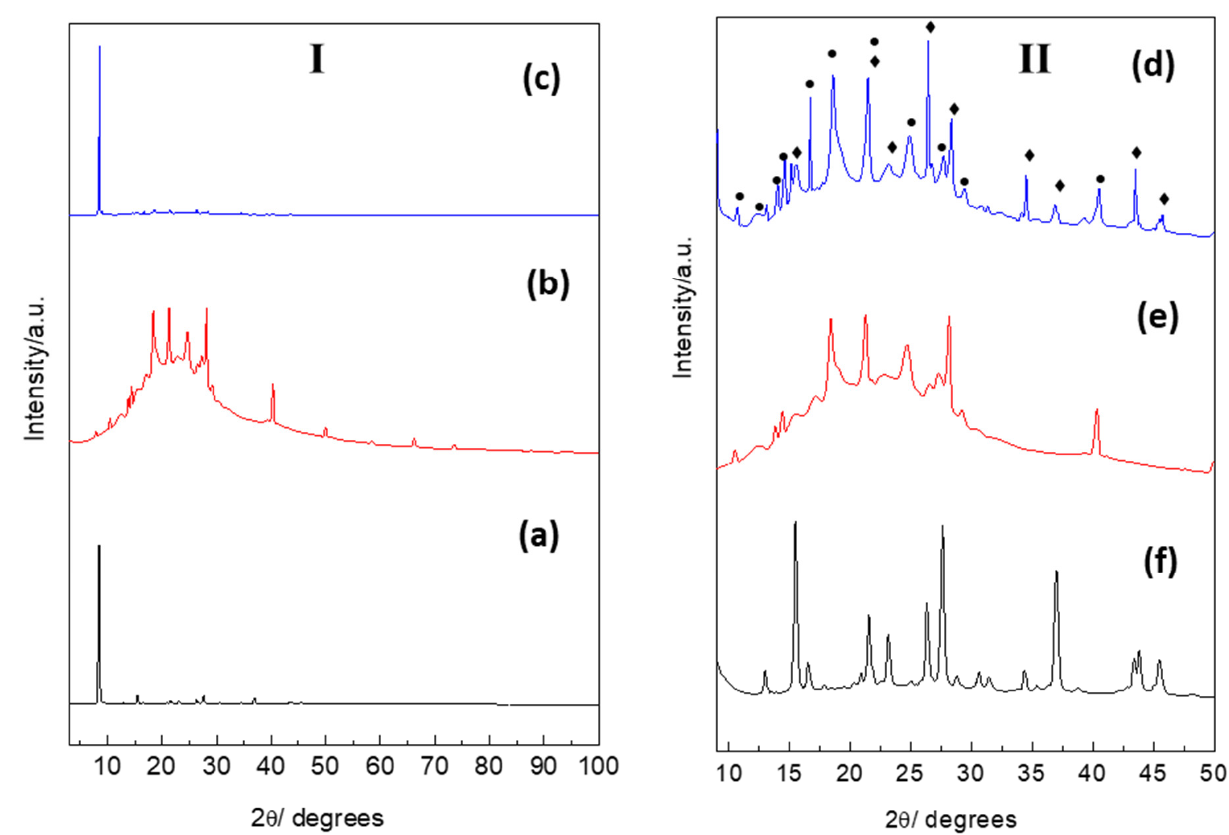
Figure 8. XRD patterns for panel [I]: ( a ) TQ powder; ( b ) polymer; ( c ) TQ–polymer nanoparticles. Panel [II] focus section from 10 to 50°: ( d ) TQ powder; ( e ) polymer; ( f ) TQ–polymer nanoparticles. Note in (II-d), the rhombus shapes over the peaks are related to TQ, while the circles are for the TQ-loaded polymer.